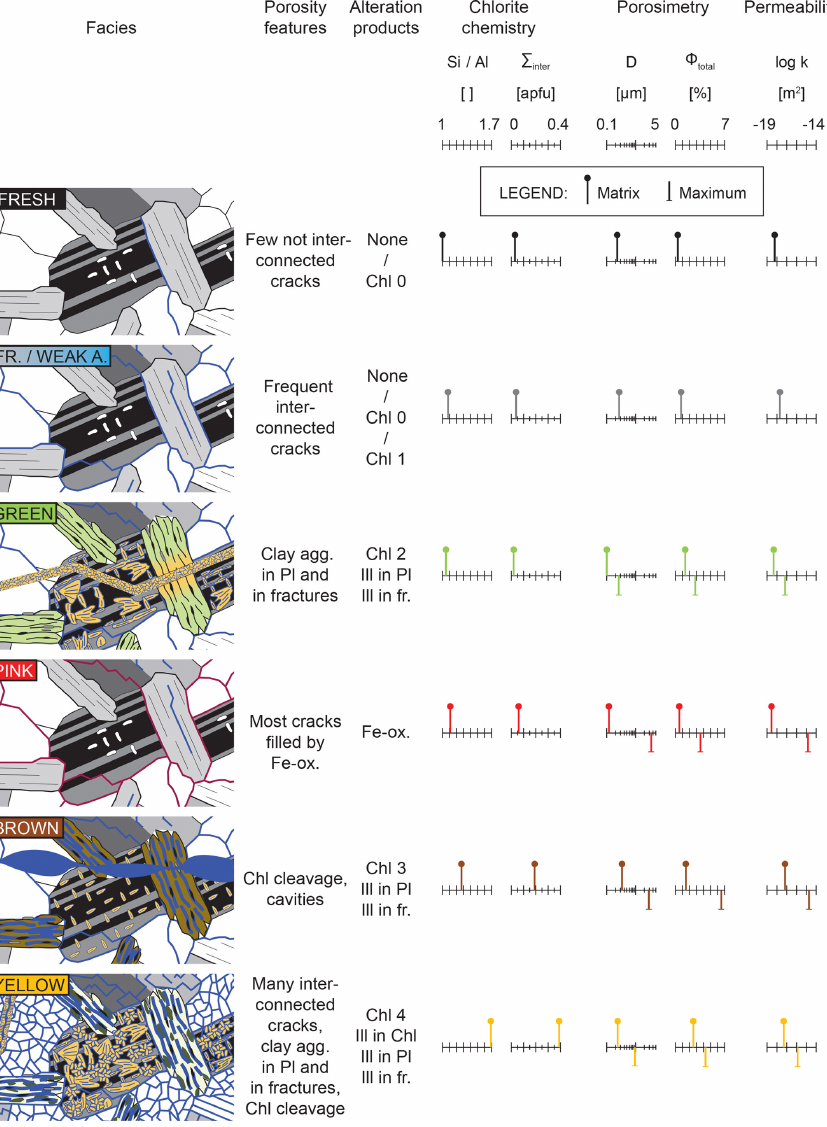
Figure 12. Synthesis of microstructural, chemical and porosimetric observations. Chl: chlorite, Pl: plagioclase, Ill: illite, Fe-ox.: iron oxides, fr.: fractured, a.: altered, agg.: aggregates, P inter : sum of interlayer cations (K, Na, Ca), D: volumetric median throat size, (cid:56) : porosity, k: permeability and apfu: atoms per formula